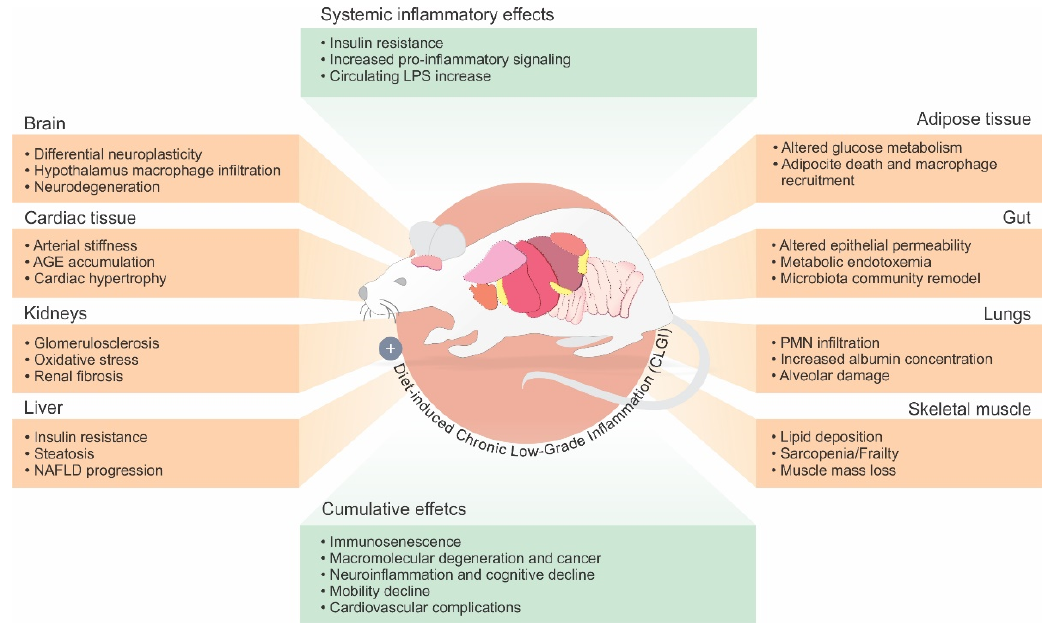
Figure 1. Physiological alterations resulting from diet-induced CLGI in different organs. CLGI is a complex crosstalk among different organs leading to an increase in local (tissue-specific) and circulating levels (systemic inflammatory effects) of inflammatory mediators. Organs and respective inflammatory mediators are referenced in Table 1. As a result, lifelong exposure to CLGI is also related to cumulative effects such as, macromolecular degeneration, neuroinflammation, and mobility reduction associate with age-related diseases with LGI components (Alzheimer’s disease). Such physiological modifications are related to the activation of inflammation, and tissue dysfunction. NAFLD = nonalcoholic fatty liver disease; PMN = polymorphonuclear leukocytes.